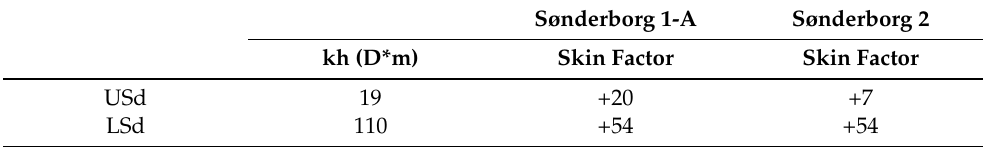
Table 3. Skin factors for Sønderborg 1-A and Sønderborg